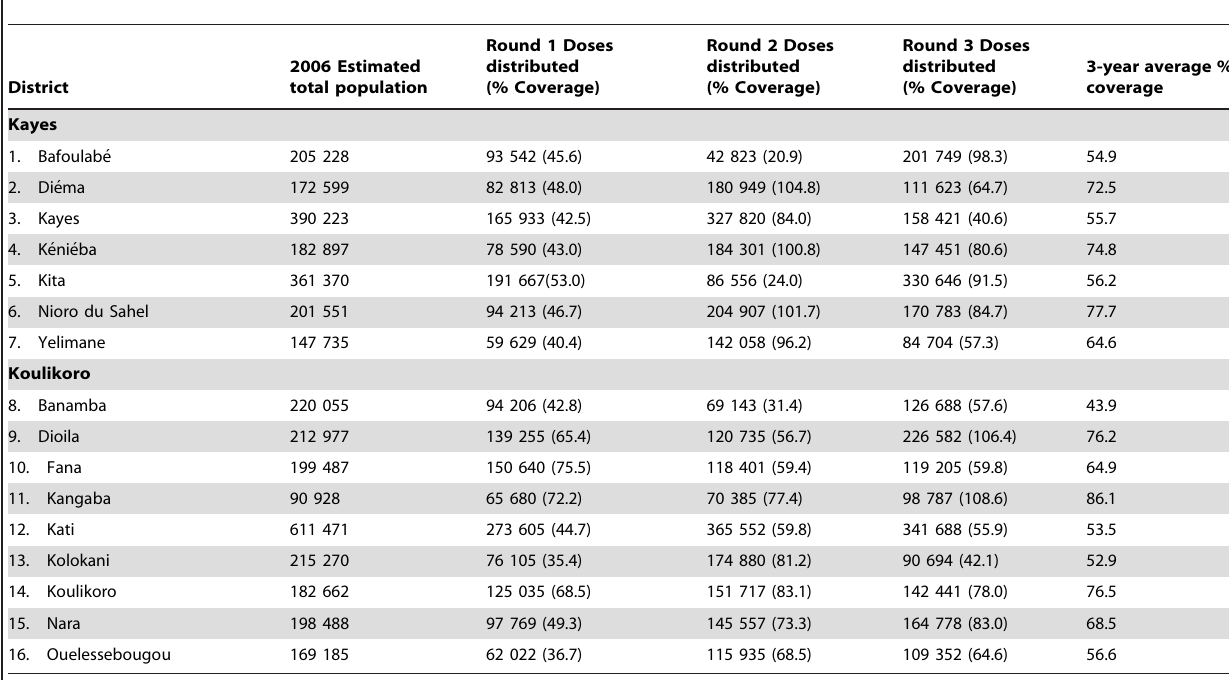
Table 2. District level antibiotic coverage of the total population in Kayes and Koulikoro Regions of Mali based on reported doses of azithromycin distributed { from